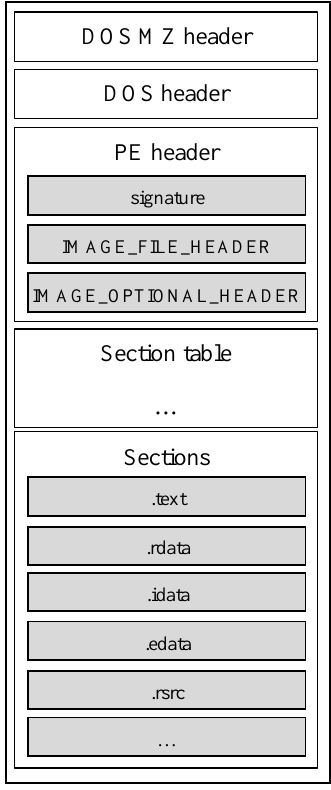
Fig. 5. Structure of PE format. Fig. 5: Structure of PE